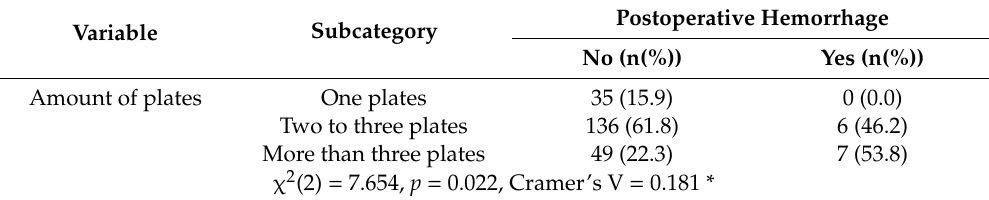
Table 11. Statistical correlation of postoperative hemorrhage with patient’s characteristics after plate removal. Patients with more than three plates su ff ered statistically significantly more from postoperative